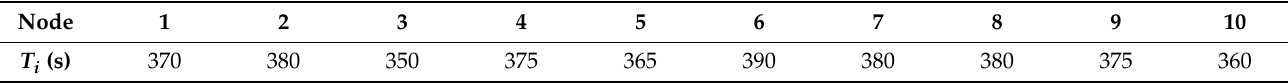
Table 2. Expected period of 10 task nodes.